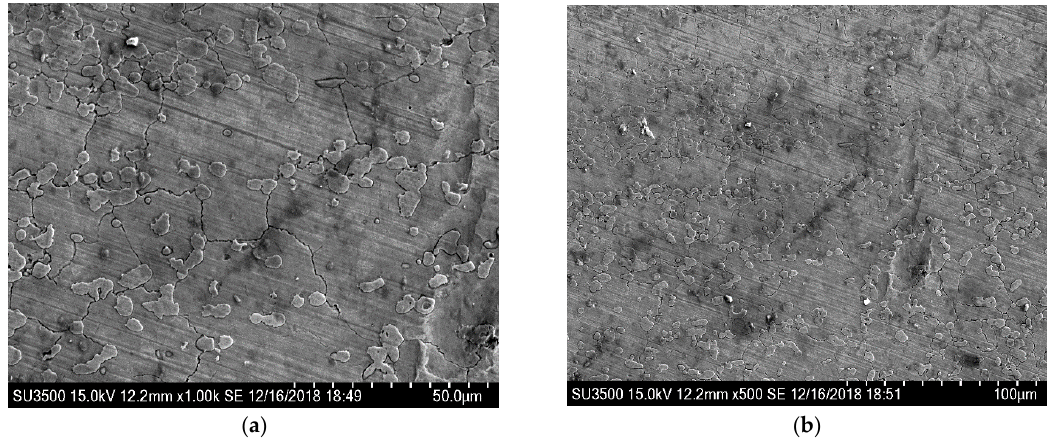
Figure 17. Micromorphology of water droplet erosion zone in stellite alloy. ( a ) ×1.0 k; ( b ) ×500.